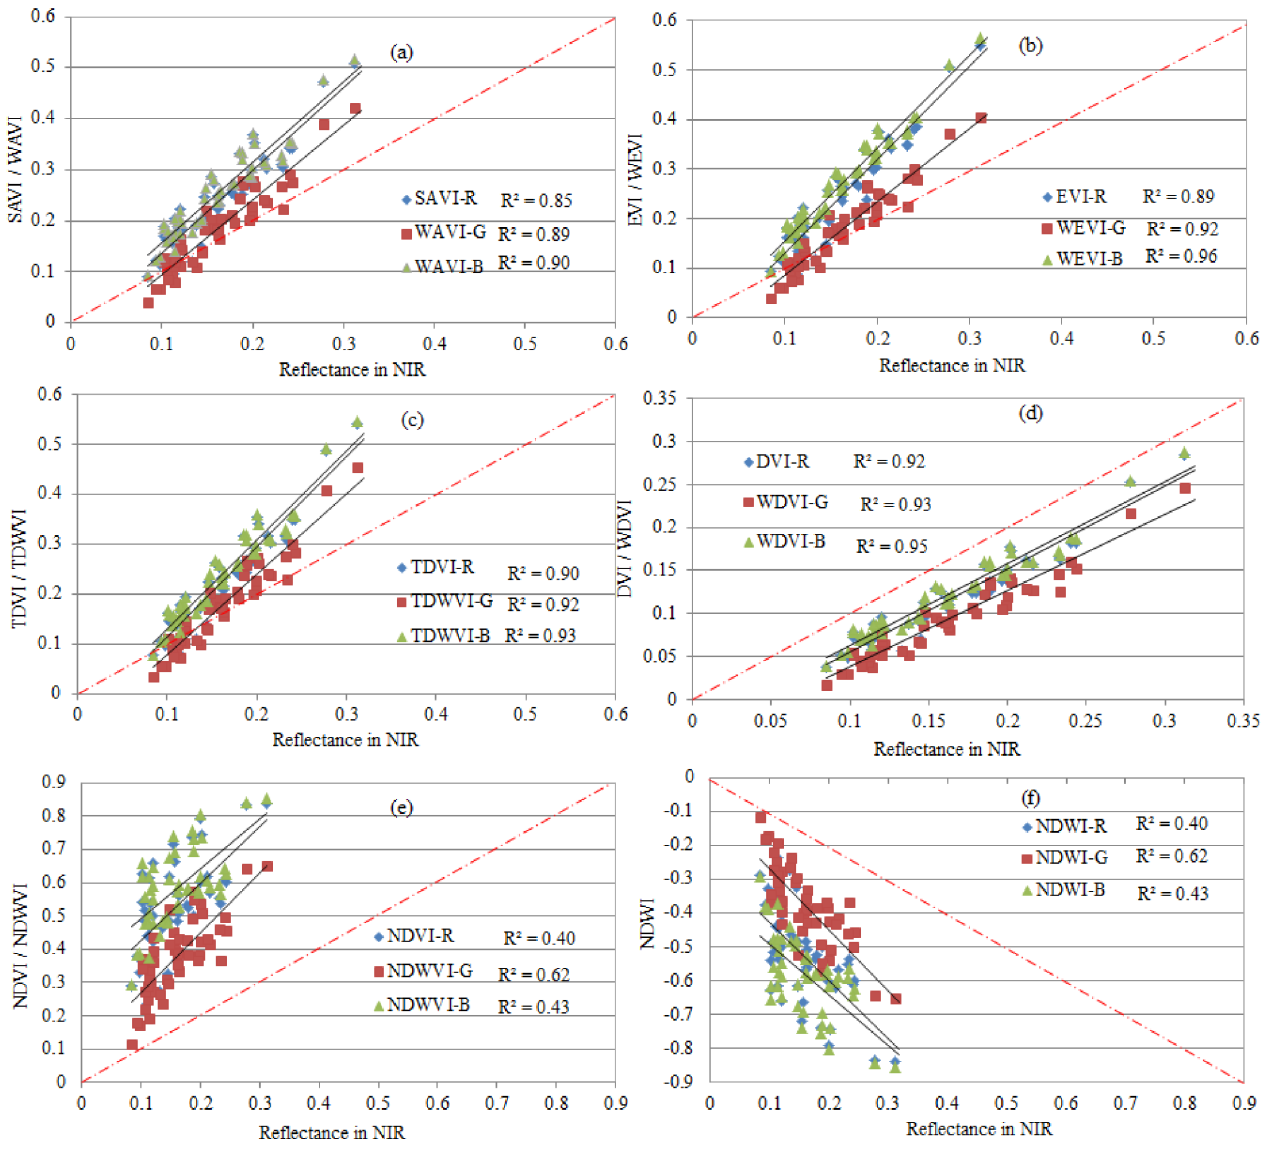
Figure 11. Linear regressions ( p< 0 . 05) between WVI and reflectance in NIR considering all samples, and integrating the red, green, and blue